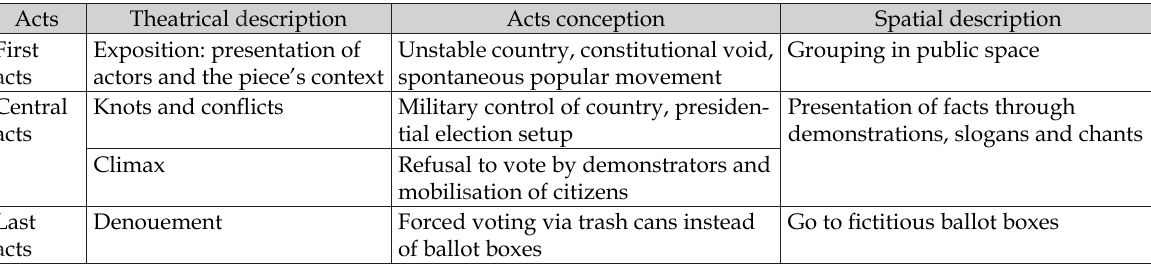
Table 2. Spatio-theatrical script design and composition of acts.